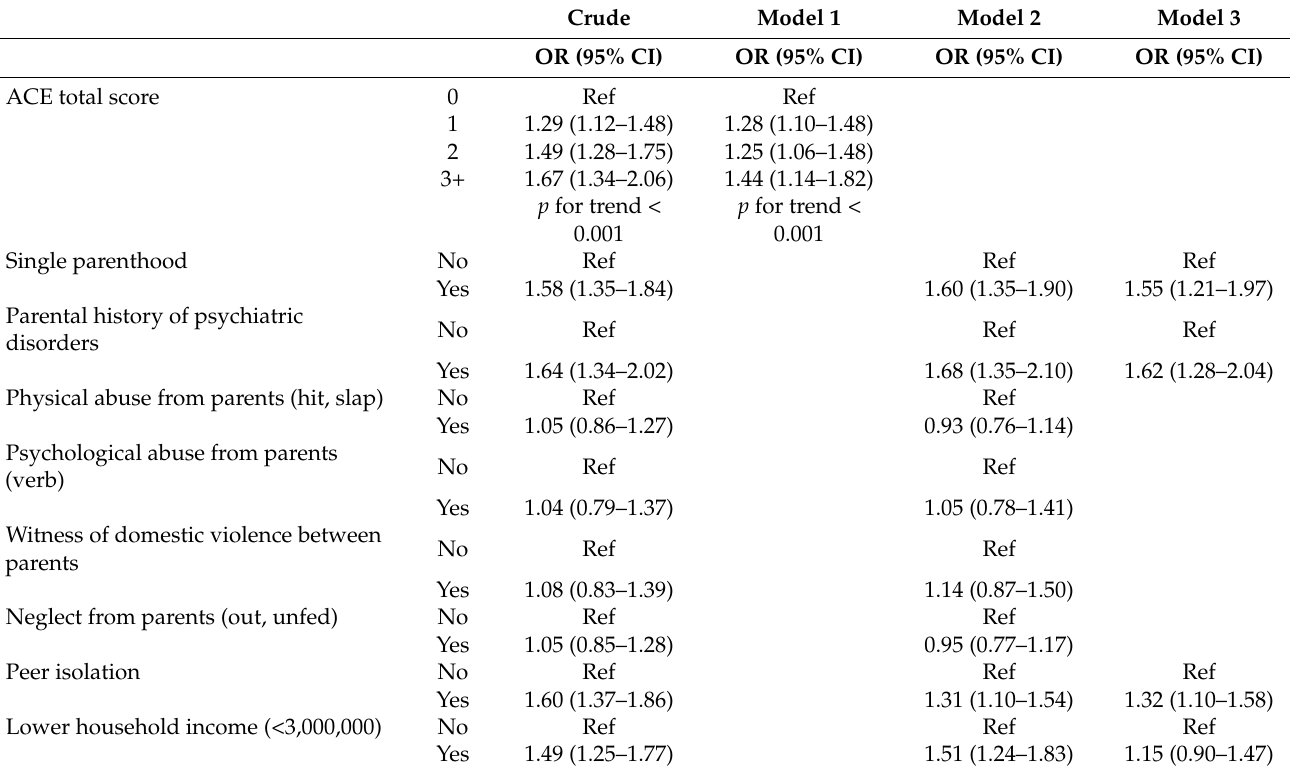
Table 4. The associations between ACEs and time spent playing video games.